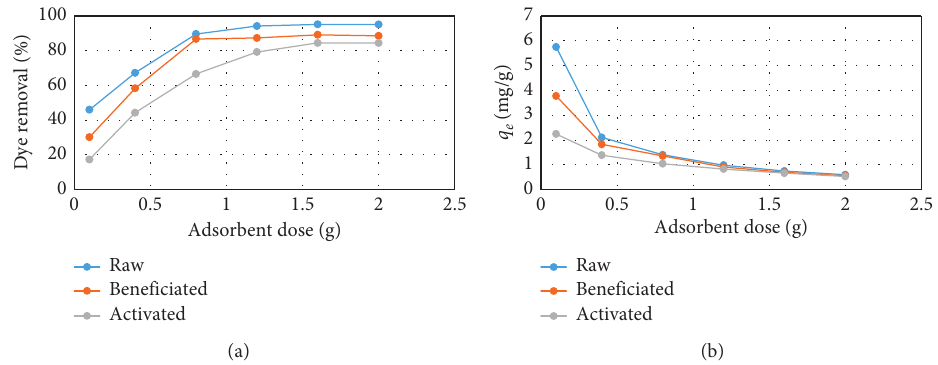
Figure 6: (a) Effect of adsorbent dosage on MB removal by raw, beneficiated, and activated waste ashes. (b) Effect of adsorbent dosage on MB adsorption capacity of raw, beneficiated, and activated waste